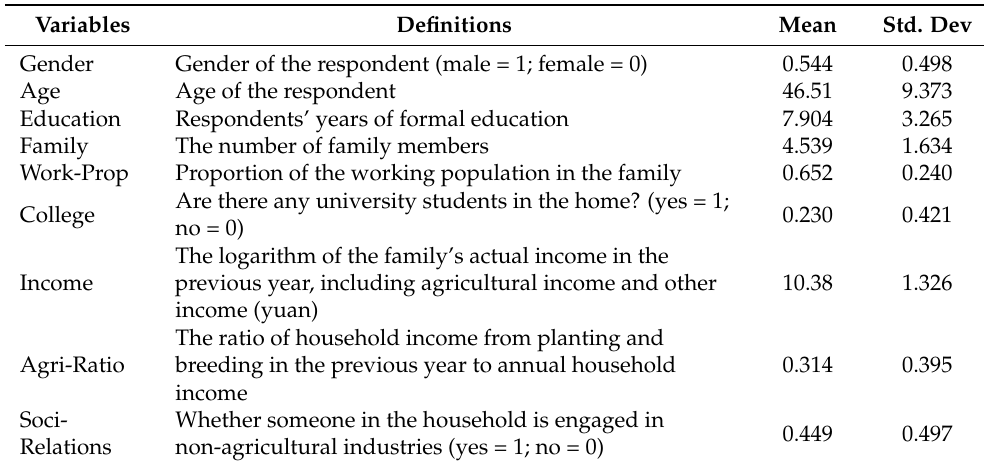
Table 7. Definition and descriptive statistics of the control